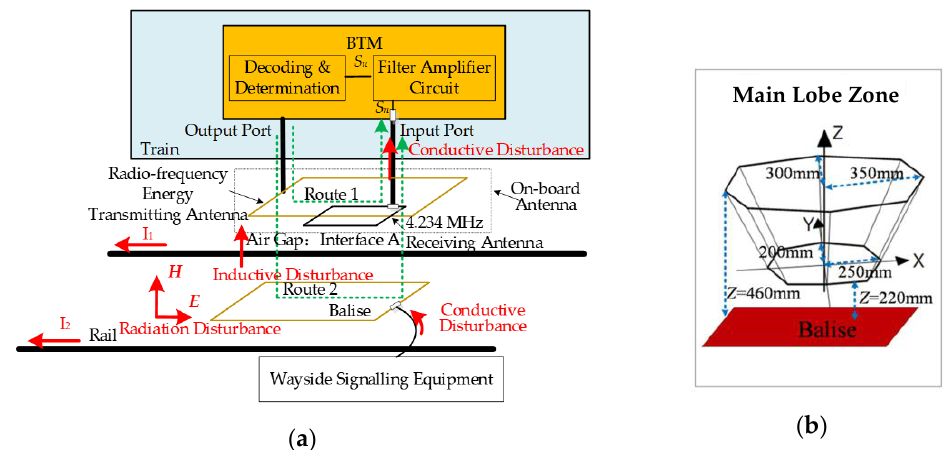
Figure 2. Operating Principle of Balise-Based Train Control System: ( a ) The route of signal and disturbance; ( b ) The contact zone.